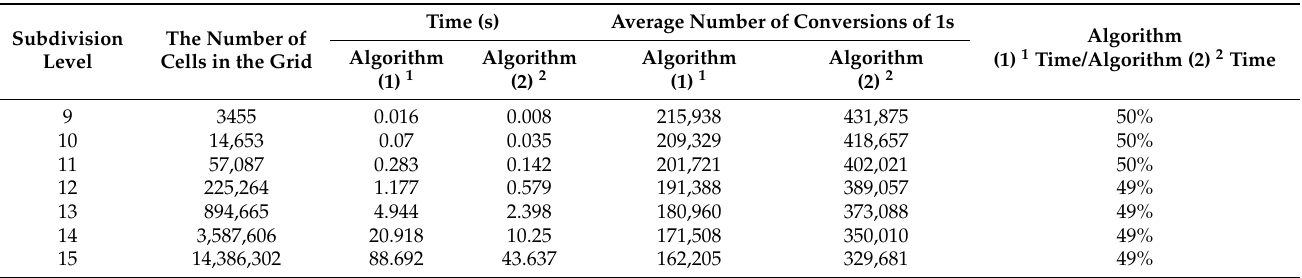
Table 8. Comparison table of the algorithms efficiency of conversion from Goodchild encoding to modified direction encoding.